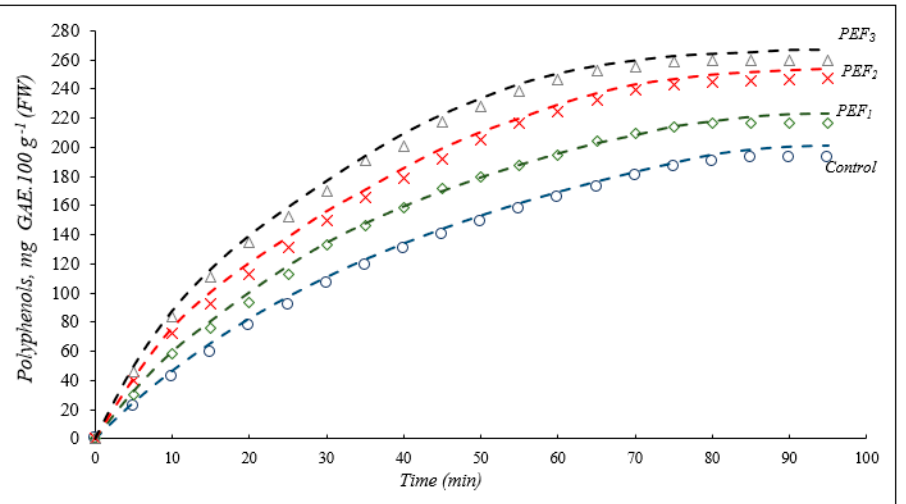
Figure 2. Effect of different treatments of PEF (PEF 1 = 1 KV.cm − 1 , PEF 2 = 2 KV.cm − 1 , and PEF 3 = 2.5 KV.cm − 1 ) on the polyphenolics extraction during diffusion at 20 ◦ C (Each experiment was repeated three times).